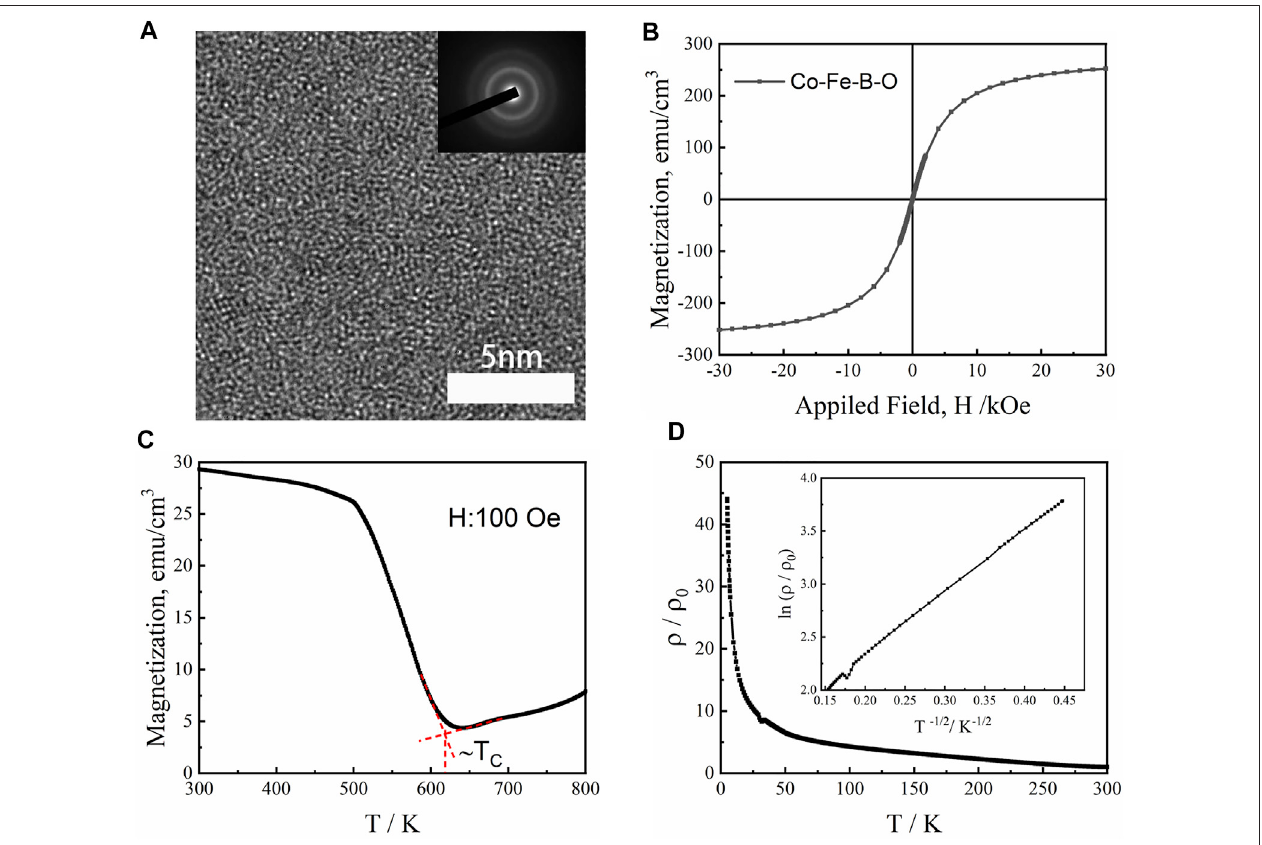
FIGURE9|(A) HRTEM imageofCo-Fe-B-O thin fi lms. TheinsetistheSAED patterns. (B) Magnetic behavior oftheCo-Fe-B-O: Magnetic fi elddependence ofthe magnetization ( M – H ) curves measured at room temperature. (C) High-temperature magnetization-temperature( M – T )curve measuredat anexternal fi eld of100 Oe. (D) The normalized resistivity ρ / ρ 0 as a function of temperature ( ρ 0 is the room temperature resistivity) for the thin fi lm. Inset is the plot of ln ( ρ / ρ 0 ) versus T − 1/2 based on the experimental